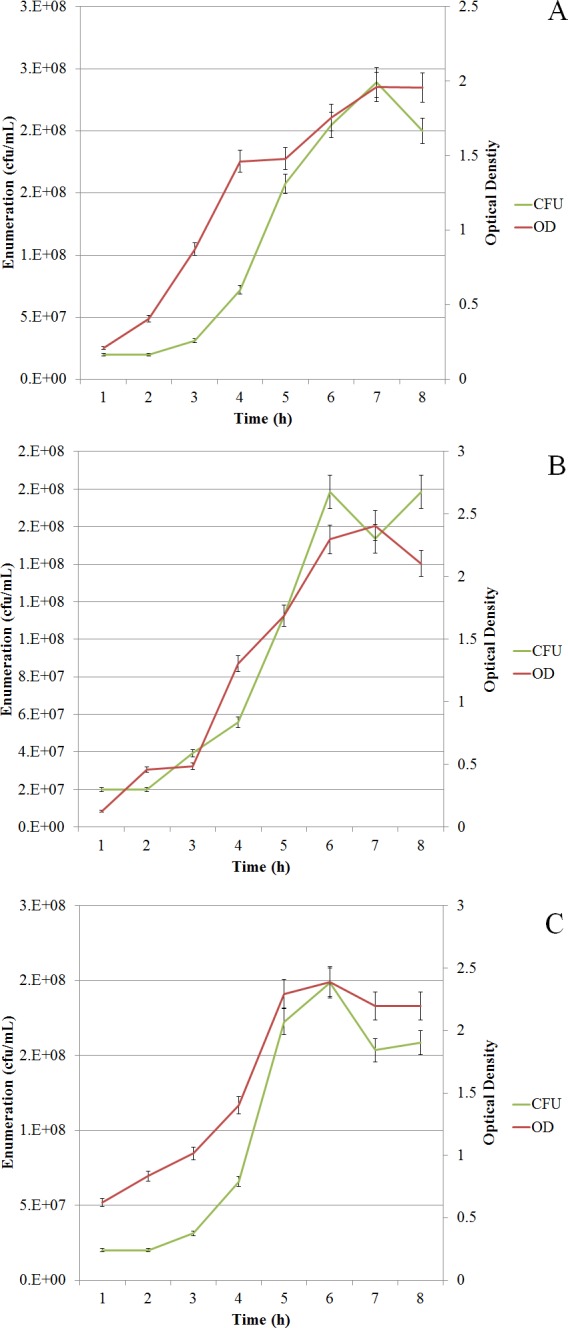
Growth curves of L. lactis.L. lactis was grown at 30 °C with agitation (150 rpm) (A), 30 °C without agitation (B), and 37 °C without agitation (C). Growth was monitored using plate counts (cfu/mL) and optical density (OD600). The sampling point for harvesting cell pellets was determined after five hours of cultivation (mid-exponential phase). Values are given as the mean ± standard deviation (n = 5, biological replicates).